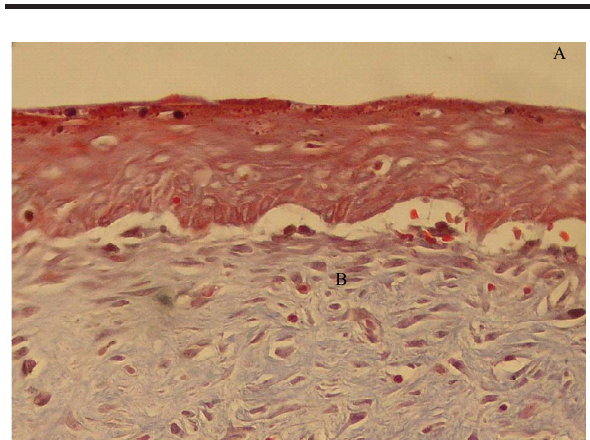
FIGURA 12 - Fotomicrografia do grupo controle do 14º dia. Nota: Epitelização parcial (A), moderada proliferação de fibroblastos (B). (H-E com aumento de 40x).